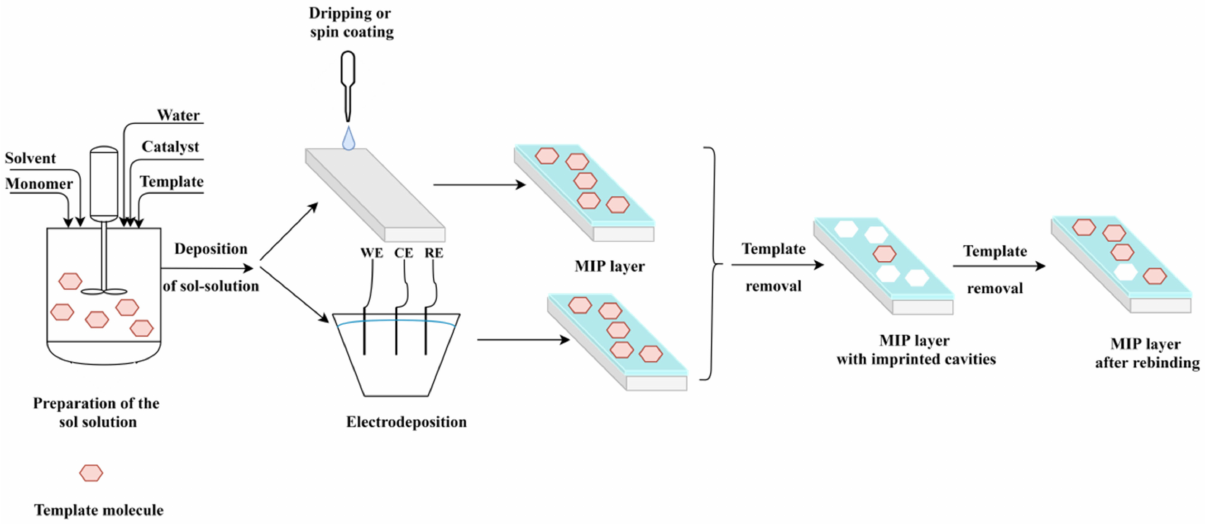
Figure 6. Sol–gel and combined sol–gel/electropolymerization methods for the preparation of MIP